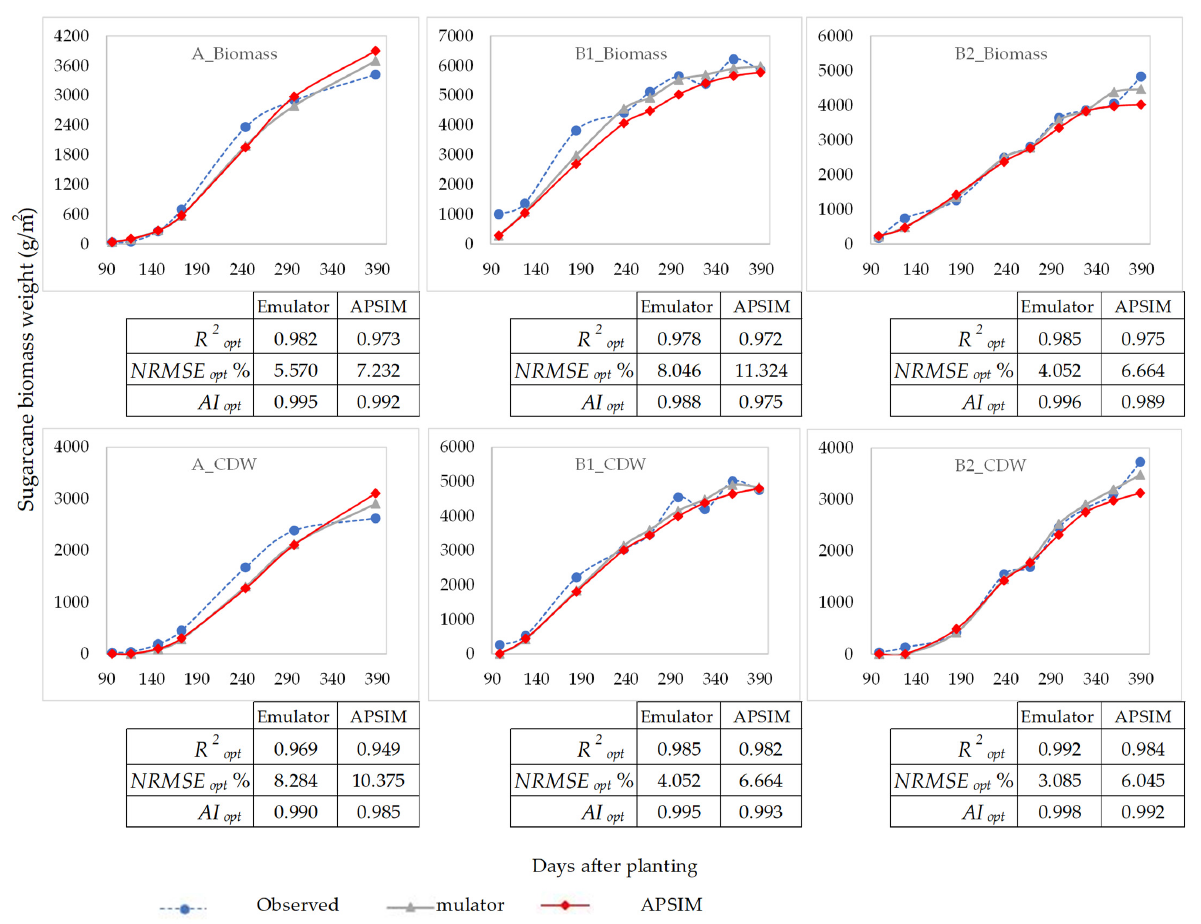
Figure 6. Comparison between simulated (both from emulator and APSIM) and observed biomass and CDW for cultivar KK3 in experiments A, B1 and B2. NRMSE opt %: Normalized root mean square error percentage, 𝑅 (cid:3042)(cid:3043)(cid:3047)(cid:2870) : Coefficient of determination and AI opt : Agreement index.